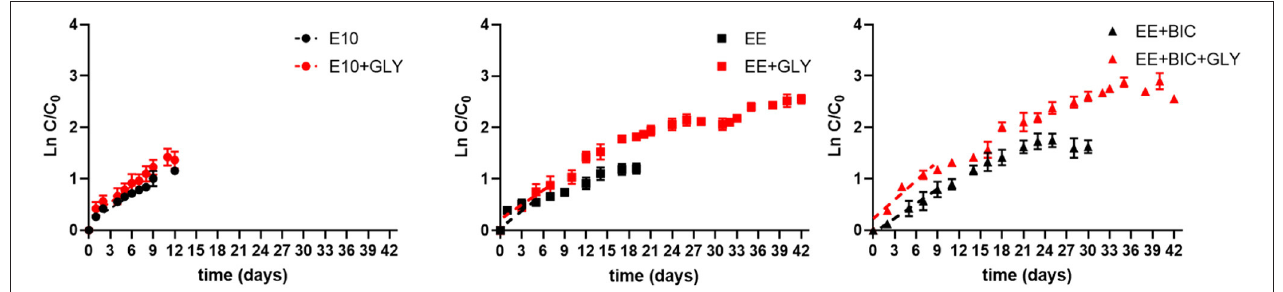
FIGURE 5 | Scale-up to photobioreactors. Log plot of growth curves in 2-L fermentor in E10 (circle), EE (square), and EE+ BIC (triangle) in both phototrophic (black) and mixotrophic (red) modes. C is the biomass concentration expressed in g/L at any time, and C0 is the initial biomass concentration. Dotted lines represent the regression curve during the exponential phase of growth (1–6 days). The slopes of the curve (growth rates) of each media under phototrophy and mixotrophy conditions are shown in Table 4 . Results are expressed as mean ± stdev with n values as stated in Table 4